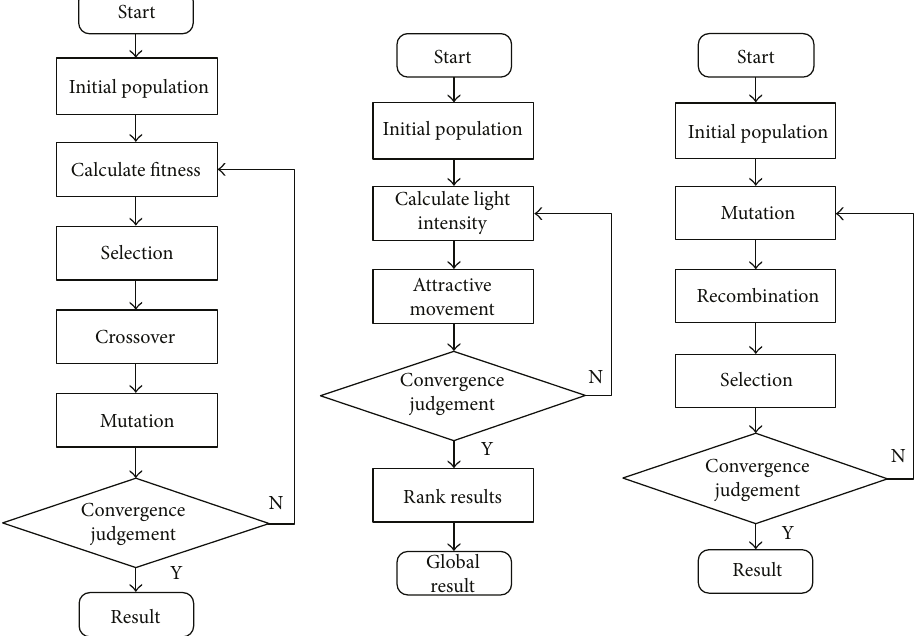
Figure 1: Process of GA, FA, and DE.